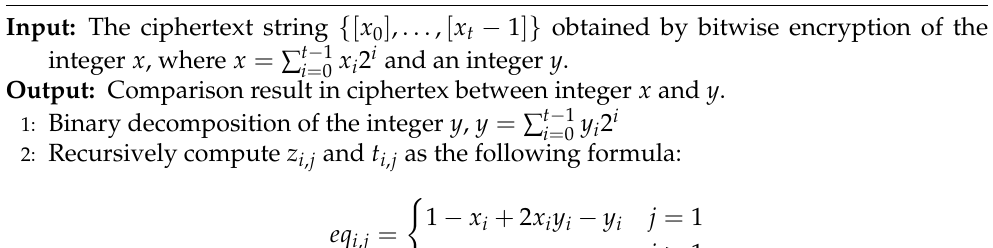
Algorithm 1 CMP ([ x ] , y ) : Compare the encrypted x and integer